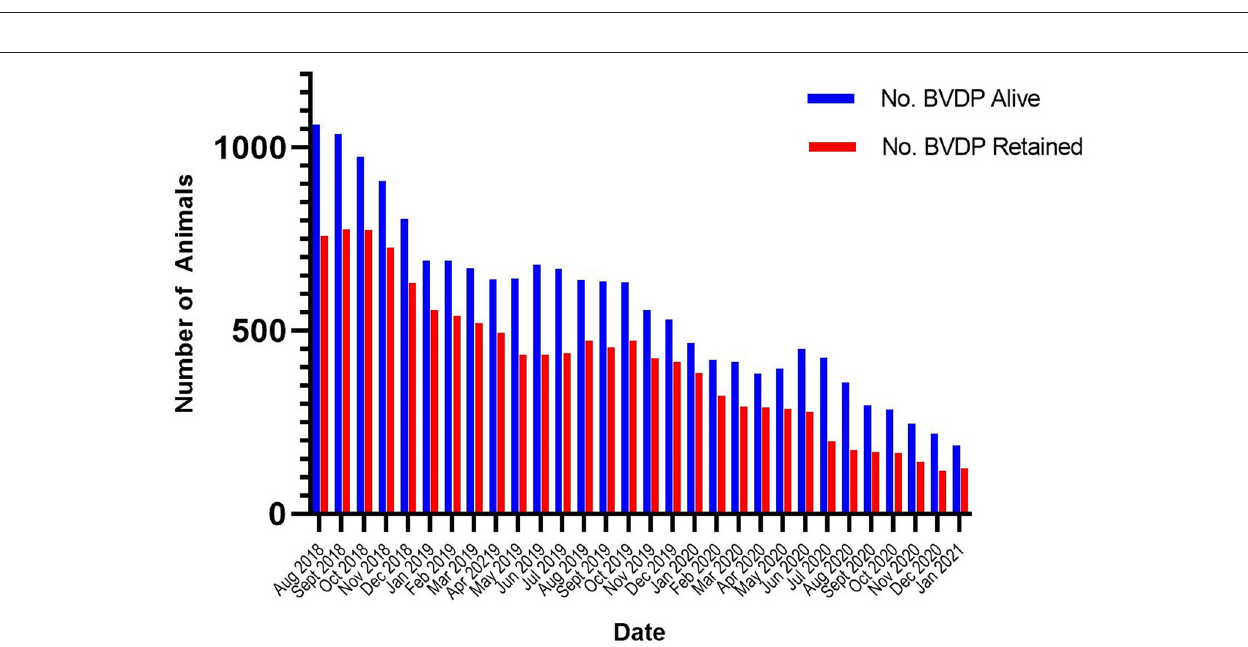
FIGURE 7 | The number of all BVDv positive (BVDP) animals alive and the number of BVDP animals alive 35 days after disease status disclosure at the start of consecutive months from July 2018 to January